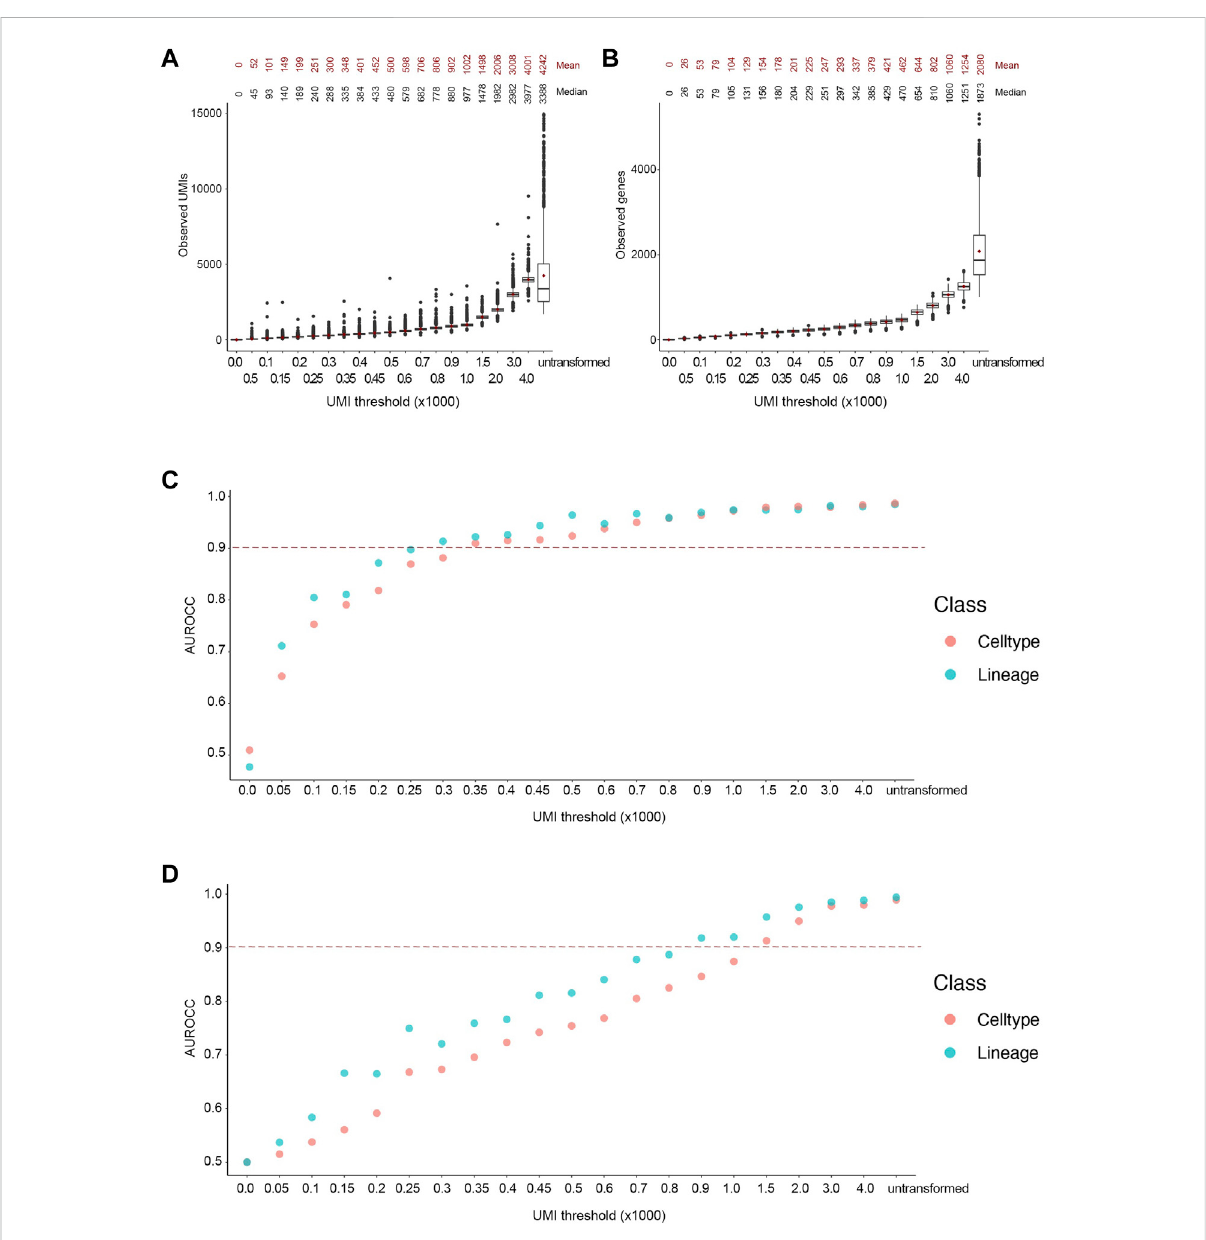
FIGURE 3 Accurate lineage and cell type classi fi cation at 450 UMIs in the FELINE dataset. (A,B) Boxplot showing the post-transformation distributions of observed UMIs (A) and number of unique genes (B) across all thresholds and untransformed control. Mean and median values for each distribution are denoted. (C,D) Area under the receiver operating characteristic curve (AUROCC) values are shown for the raw (untransformed) counts as well as the downsampled counts at different thresholds using the SingleR model (C) and the SingleCellNet model (D) . The AUROCC values for both lineage and cell type assessments are shown for each model as well as the selected AUROCC cut-off value ( > 0.9), dashed